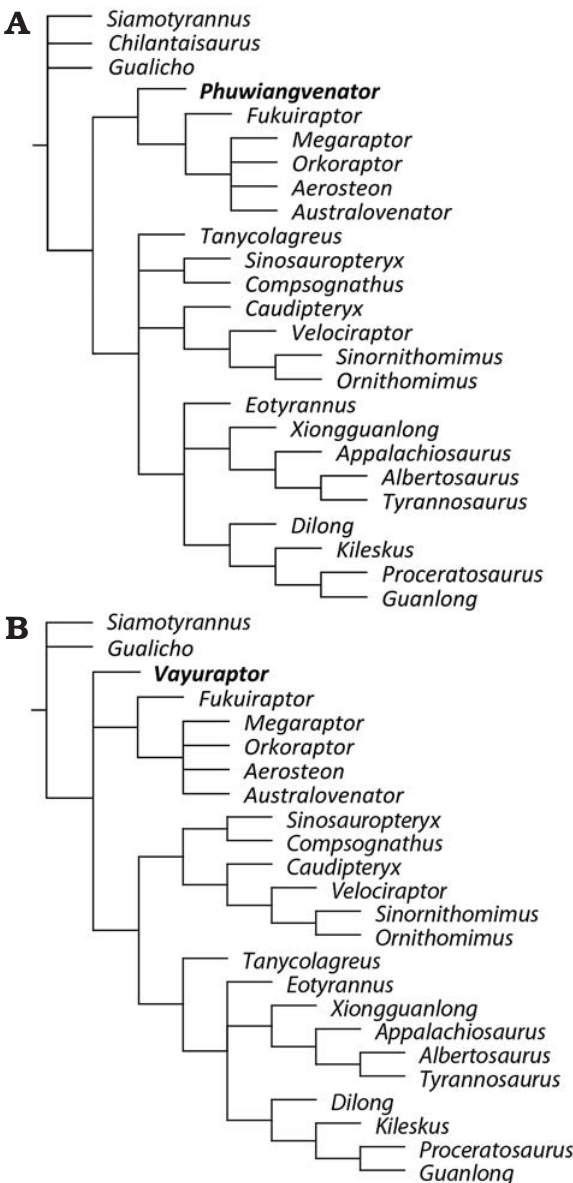
Fig. 18. Strict consensus trees of all the recovered MPTs of the phylogenetic analyses from the present study (modified from Apesteguía et al. 2016). A . Data matrix including Phuwiangvenator yaemniyomi gen. et sp. nov. B . Data matrix including Vayuraptor nongbualamphuensis gen. et sp.